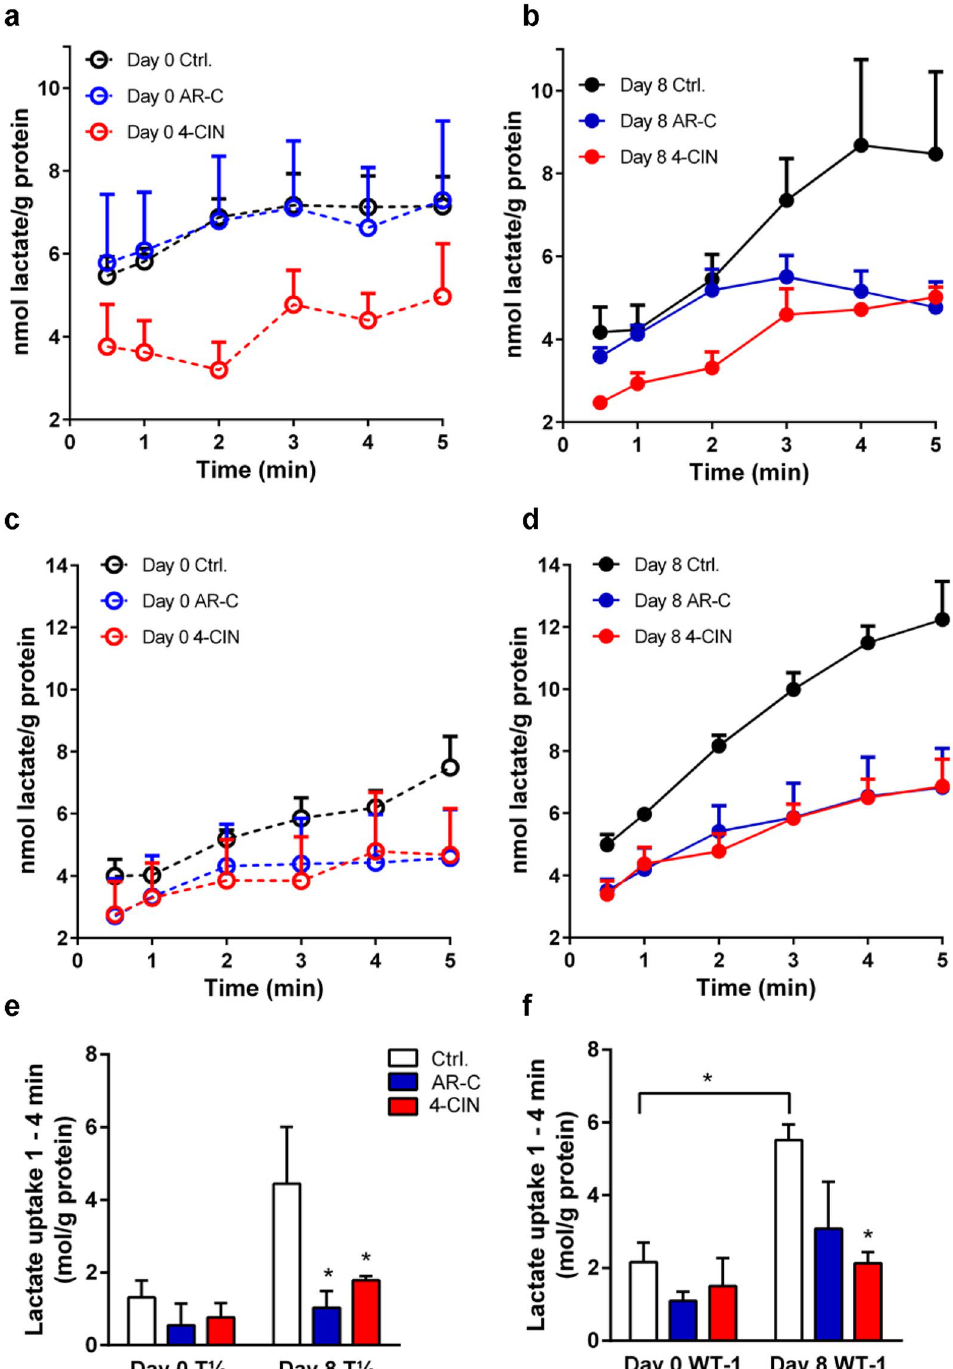
Figure 4. Lactate influx in undifferentiated and differentiated adipocytes. C3H10T½ and WT-1 cells were grown to confluency and either subjected to radioactive tracer analysis of lactate influx as described in Materials and Methods at this point (day 0), or induced to differentiate and lactate influx analysis was carried out on day 8. Panels a, b, and e show data from C3H10T½ cells, panels c, d, and f show data from WT-1 cells. Where indicated, AR-C155858 (10 µ M, from 1 h prior to start of influx) or 4-CIN (5 mM, from 15 min prior to starting of influx) was present to inhibit MCT1/ − 2 or all MCTs, respectively. Data are shown either as the influx over time in nmoles/mg protein (panel a–d), or as the net influx from time 1 to 4 min ( e , f ; mean with S.E.M. error bars), and represent 3 independent biological replicates for each condition. * p < 0.05, two-way ANOVA with Dunnett’s post-test (Ctrl. vs. AR-C and 4-CIN) or Students t -test (day 0 vs day